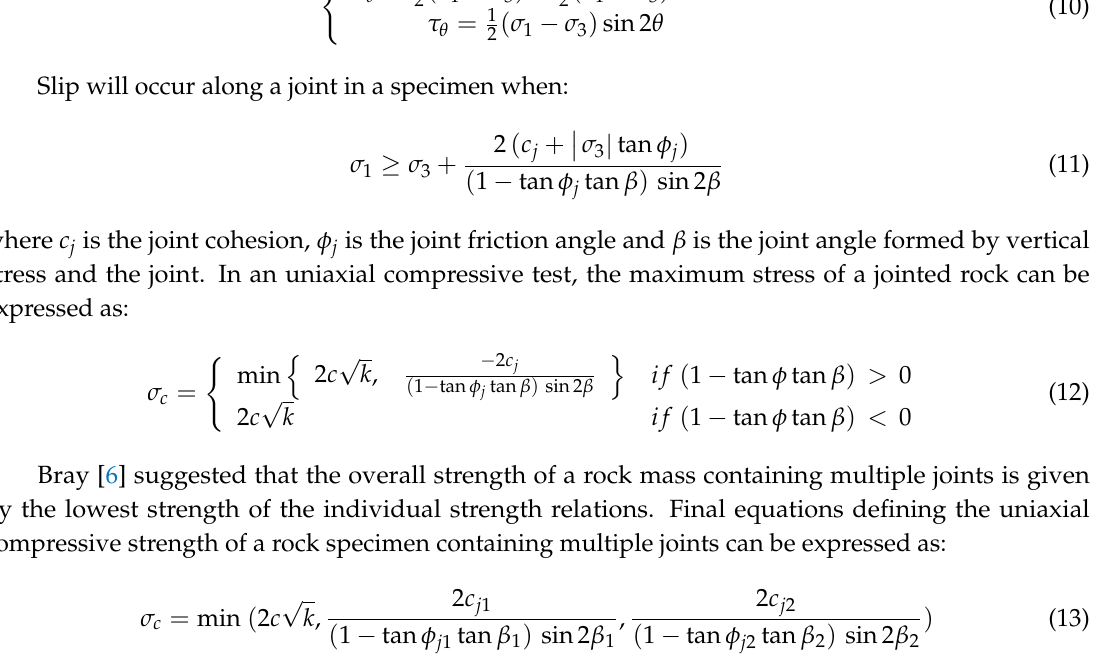
Table 2. Mechanical properties of the jointed rock mass.